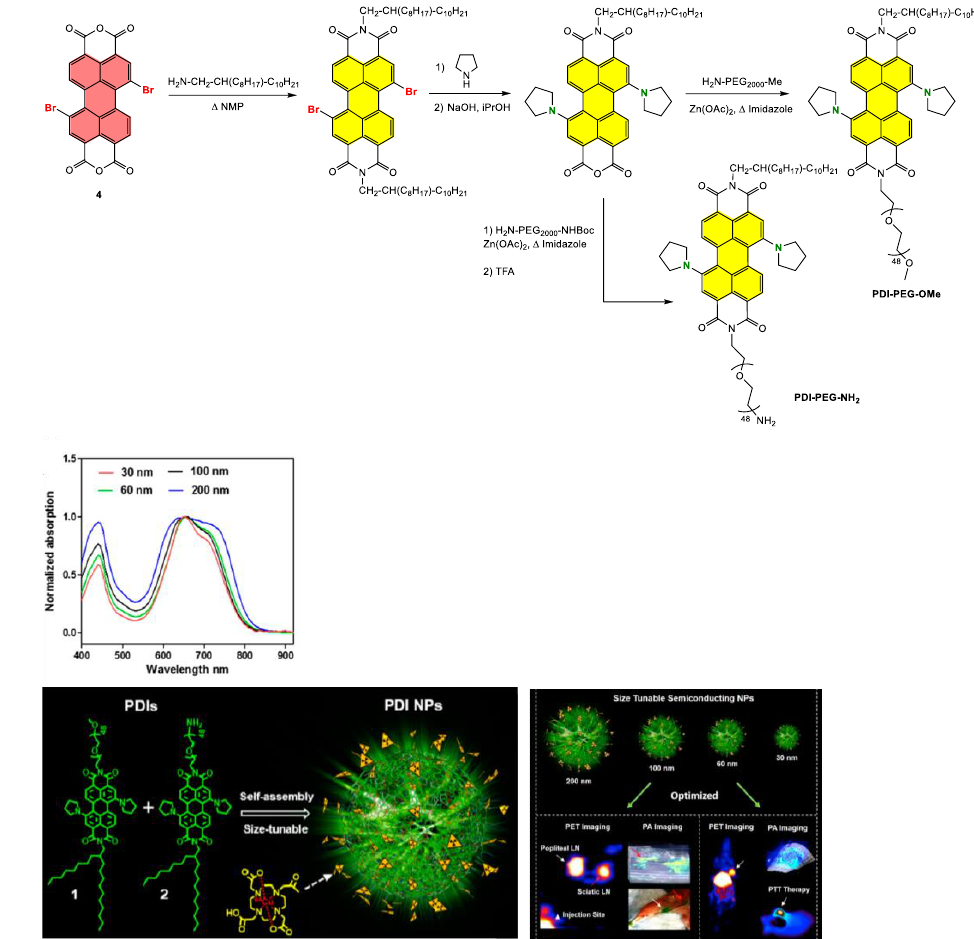
Figure 20. Synthesis of asymmetric amphiphilic PDI derivatives; normalized UV-Visible spectra of different-sized PDI NPs in water; formation of the PDI NPs and their potential applications. Reprinted with permission from reference [131]. Copyright 2017 American Chemical Society.